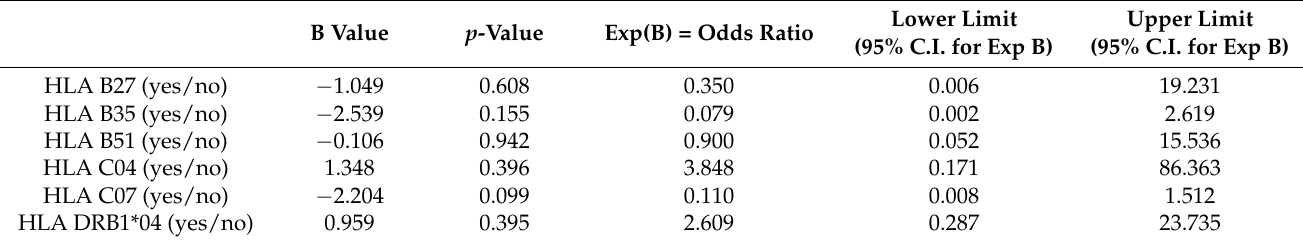
Table 4. Logistic regression analysis of HLA alleles of patients suffering from autoimmune hearing loss related to their response to treatment. yes: favorable response to therapy, no: no response to